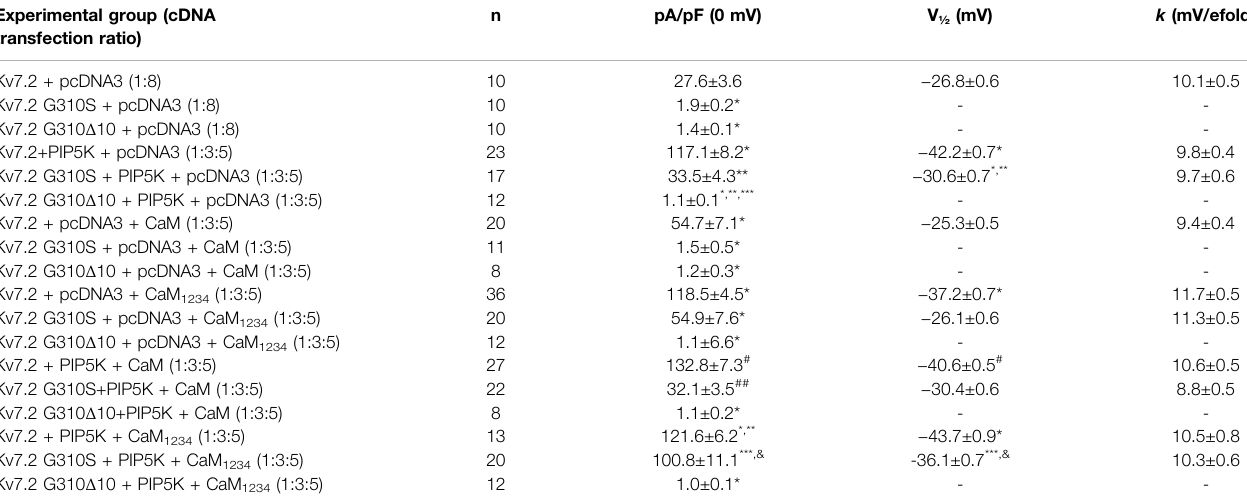
TABLE 2 | Functional properties of currents measured in CHO cells expressing wild-type or mutant Kv7.2 subunits upon modulation of PIP 2 or CaM levels. Experimental group (cDNA transfection